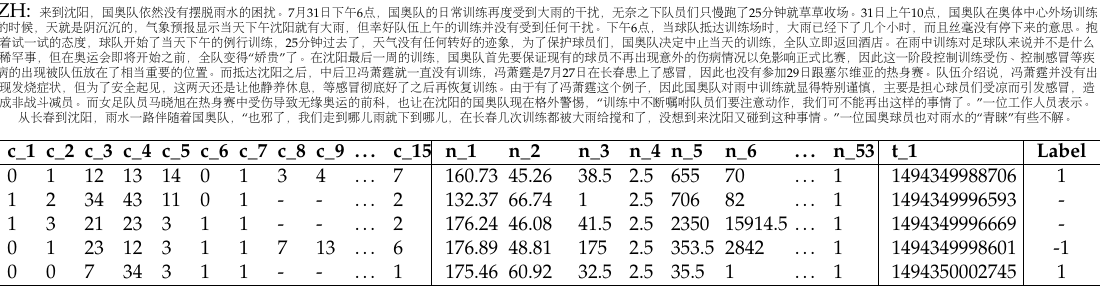
Figure 1. Samples from the AutoDL 2019 training/development datasets show the variety of tasks covered. First row : image data from photographs, medical imaging, CCTV, and aerial imaging with resolutions from 100 × 100 to 1073 × 540 pixels. Second row : video data is confined to short action sequences; here, an overview of the action types is depicted first, followed by four frames of the action “running”. Third row : waveforms and corresponding spectrograms are given for an English speech sample (speaker recognition task) and a rock music snippet (genre recognition) as audio task examples. Row four and five : a shorter English movie review and a longer Chinese news article. Last row : a sample of weakly supervised tabular data including categorical (c), numerical (n) and timestamp (t) columns as well as missing data and labels (-); neither the meaning of the features nor of the classes is disclosed to the